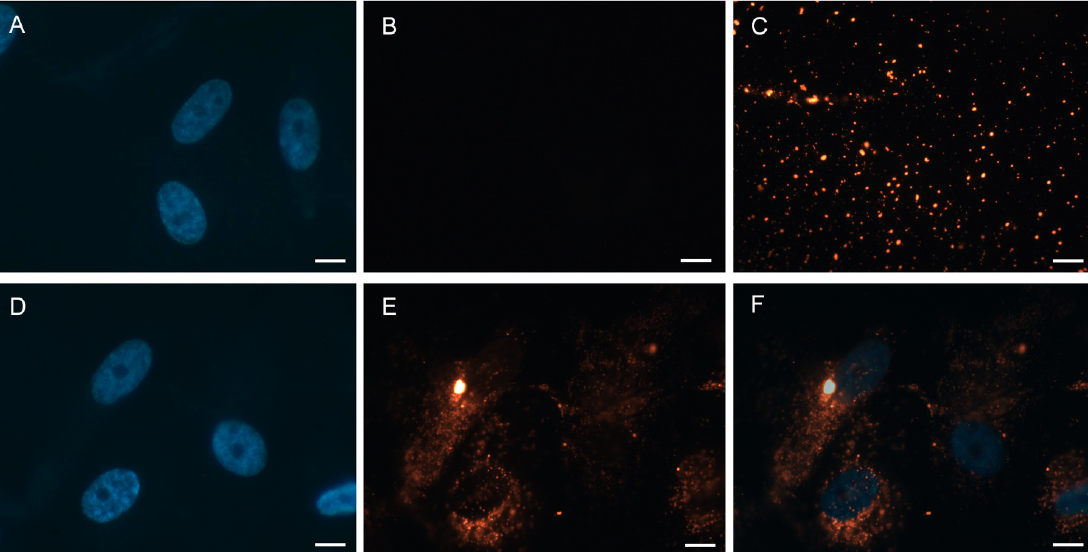
Figure 4. PKH26 staining of EVs and incorporation into cultured tubular epithelial cells (TECs). Fluorescence microscopy showed that TECs (nuclei stained with 4 (cid:48) ,6-diamidin-2-phenylindol (DAPI)) uptake PKH26-labeled EVs (red). ( A , B ) Negative control. TECs incubated with a processed PKH26 solution without EVs (( A ) nuclei staining, ( B ) red fluorescence channel). ( C ) PKH26-labeled EVs on an adhesion slide. ( D – F ) TECs incubated with PKH26-stained EVs clearly showing incorporation of labeled EVs into the cytosol of TECs (( D ) nuclei staining, ( E ) red fluorescence channel, ( F ) overlay of ( D ) and ( E )). Scale bar = 10 µ